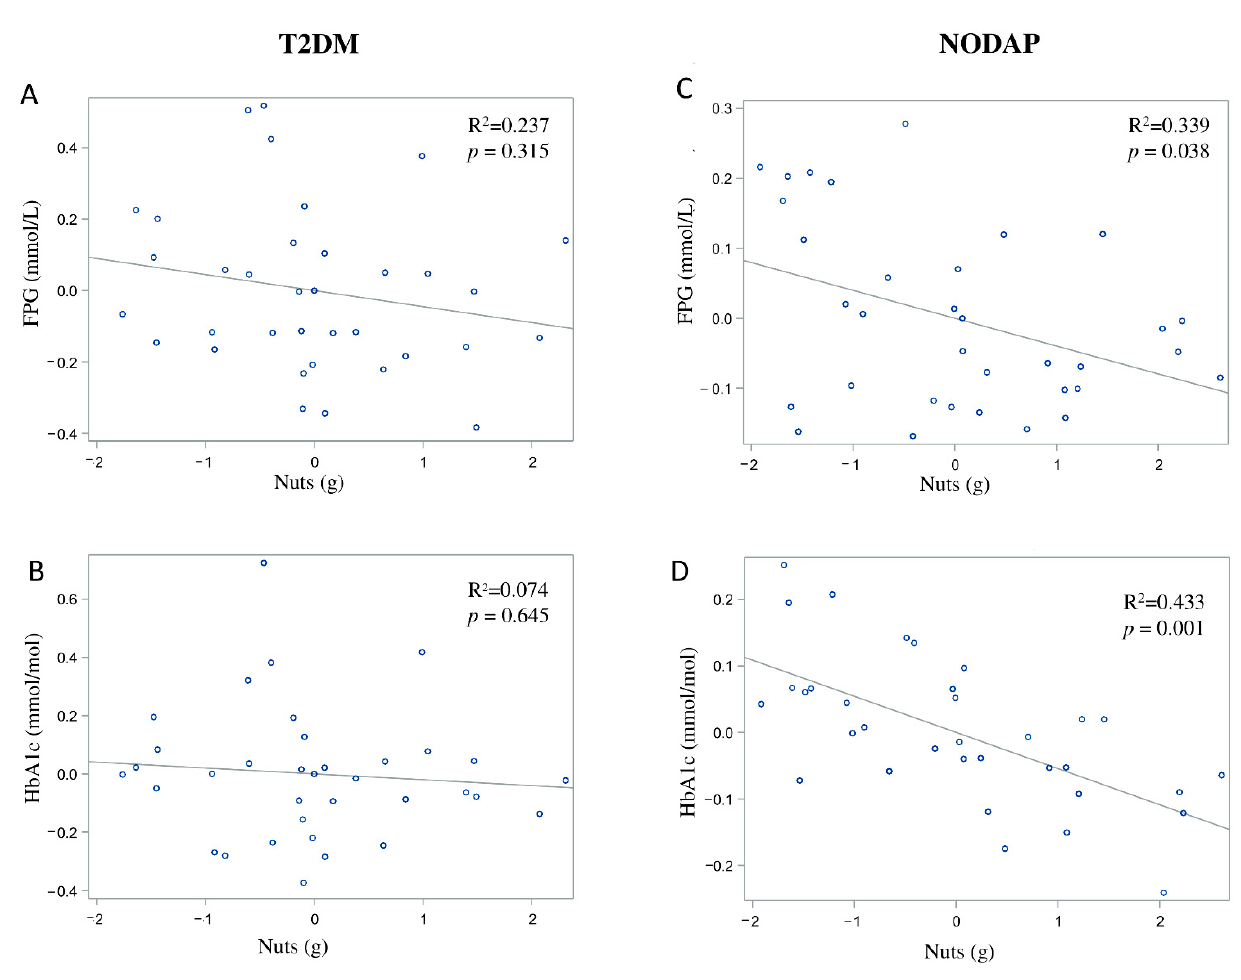
Figure 5. Associations between nuts intake and markers of glucose metabolism between T2DM ( A , B ) and NODAP group ( C , D ). Abbreviations: T2DM = Type 2 diabetes or prediabetes prior to acute pancreatitis. NODAP = New-onset diabetes or prediabetes after acute pancreatitis. HbA1c = glycated haemoglobin. FPG = fasting plasma glucose. R 2 = adjusted R 2 value (coefficient determinations). Footnotes: FPG, HbA1c, and nuts were log-trans. R 2 values were adjusted for age, sex, BMI, energy intake (log-transformed), use of anti-diabetic medications, aetiology of pancreatitis, recurrence of pancreatitis, and presence of pancreatic necrosis.